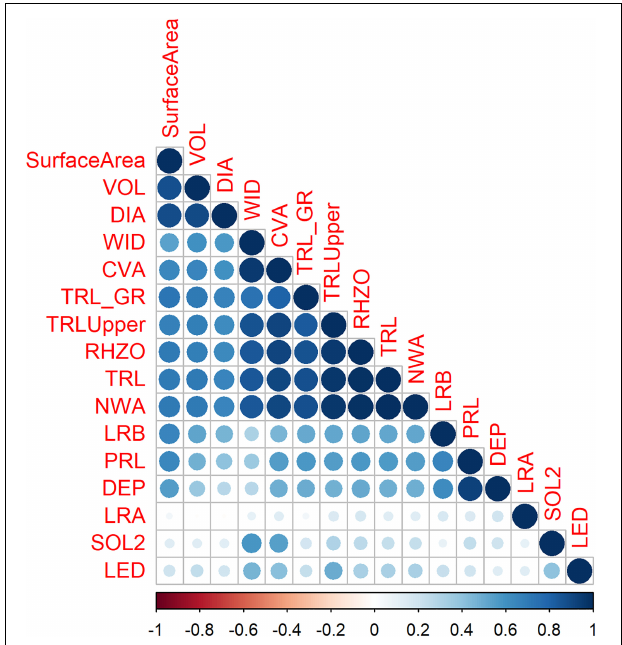
FIGURE 2 | Correlations among the root traits at day 15 using the Iowa (IA) mung bean panel. Experiments were conducted in controlled environment chambers and included eight